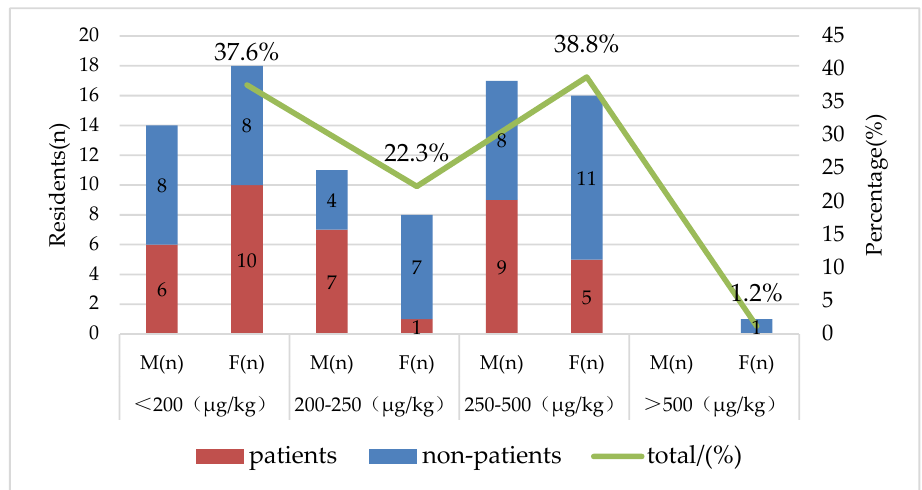
Figure 2. Distribution of hair selenium content in the study area (M: Male, F: Female, n : number).